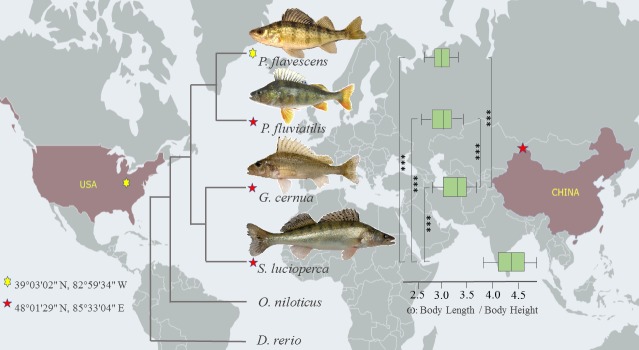
Sampling location, phylogenetic tree, and multiple comparison of ratios of body length / body height (ω) among four Percids.***: significant difference (p < 0.01) revealed from nonparametric multiple comparisons (npmc) using the “npar” package in R 3.5.3.